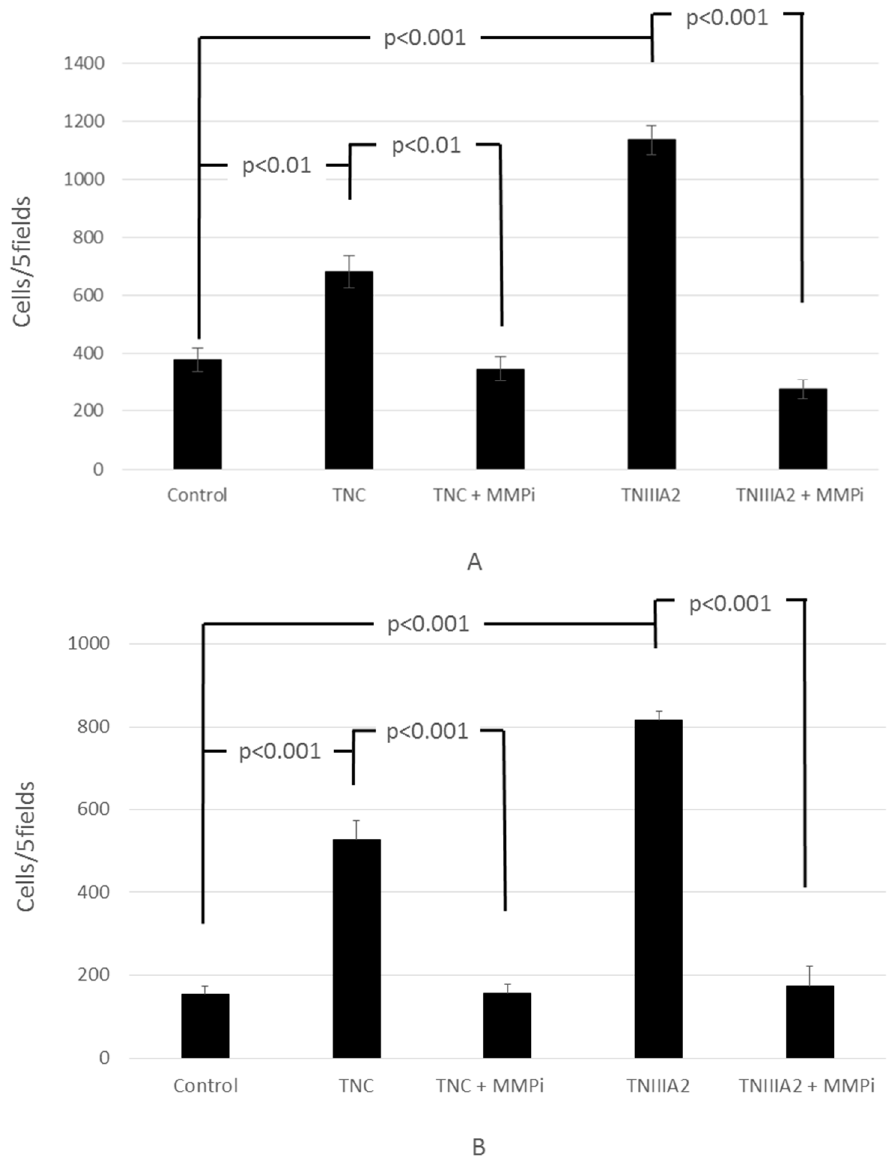
Figure 3. The enhanced invasion of Colon26-M3.1 ( A ) or PMF-Ko14 ( B ) by TNC and TNIIIA2 is dependent on Matrix metalloproteinase (MMP). Colon26M3.1 cells (3.0 × 10 4 cells/200 µ L/well) or PMF-Ko14 cells (3.0 × 10 4 cells/100 µ L/well) were seeded onto the upper compartment of the invasion chamber with TNC (10 µ g/mL) or TNIIIA2 (12.5 µ g/mL) and an MMP inhibitor (100 µ M) and were allowed to invade for 24 h. Cells that invaded the lower surface of the membranes were counted. Data represent the mean of three determinations ± SD.